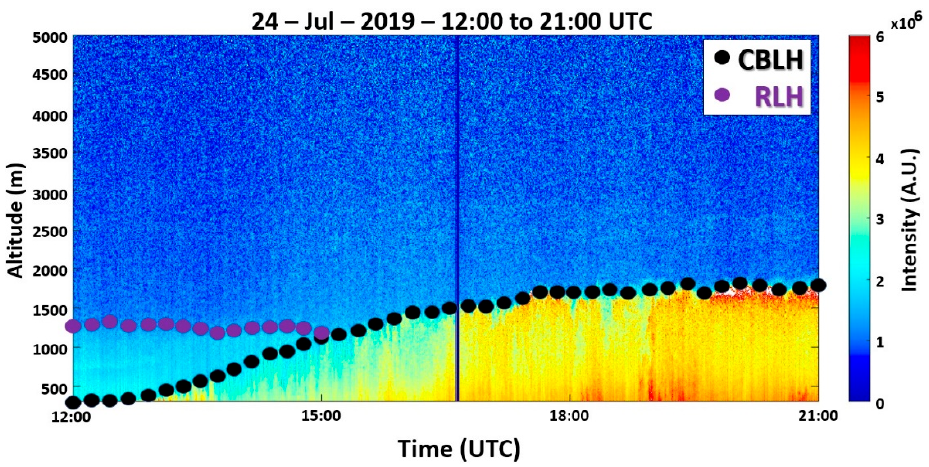
Figure 14. RCS 532 profiles from 12:00 UTC to 21:00 UTC on 24 July 2019. The black dots represent the CBLH, and the purple dots represent the RLH. The color bar represents the intensity of the RCS 532 .